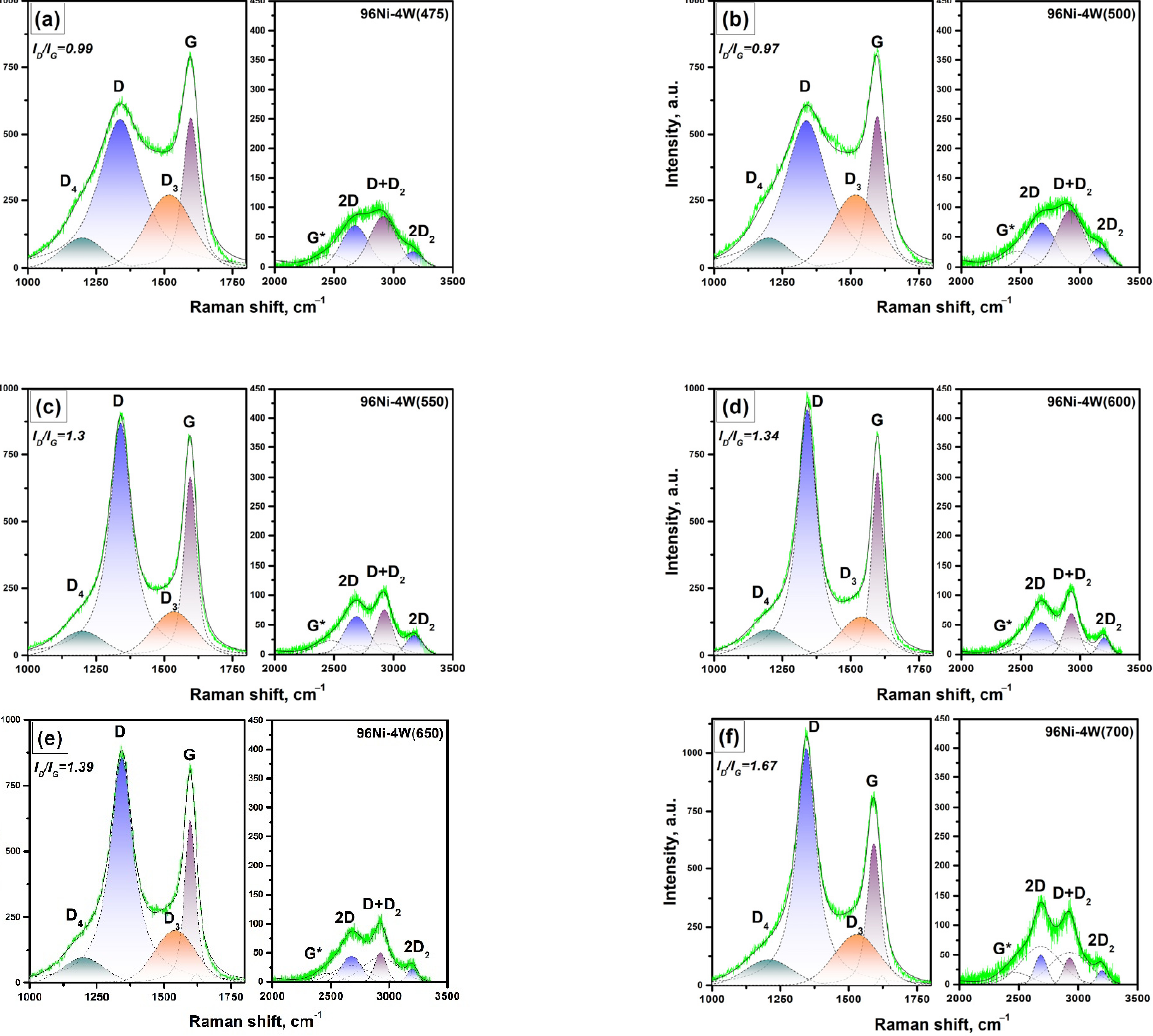
Figure 9. Raman spectra of the carbon product formed over the 96Ni-4W samples for a region of the bands of first and second orders: ( a ) 96Ni-4W(475); ( b ) 96Ni-4W(500); ( c ) 96Ni-4W(550); ( d ) 96Ni-4W(600); ( e ) 96Ni-4W(650); ( f ) 96Ni-4W(700).